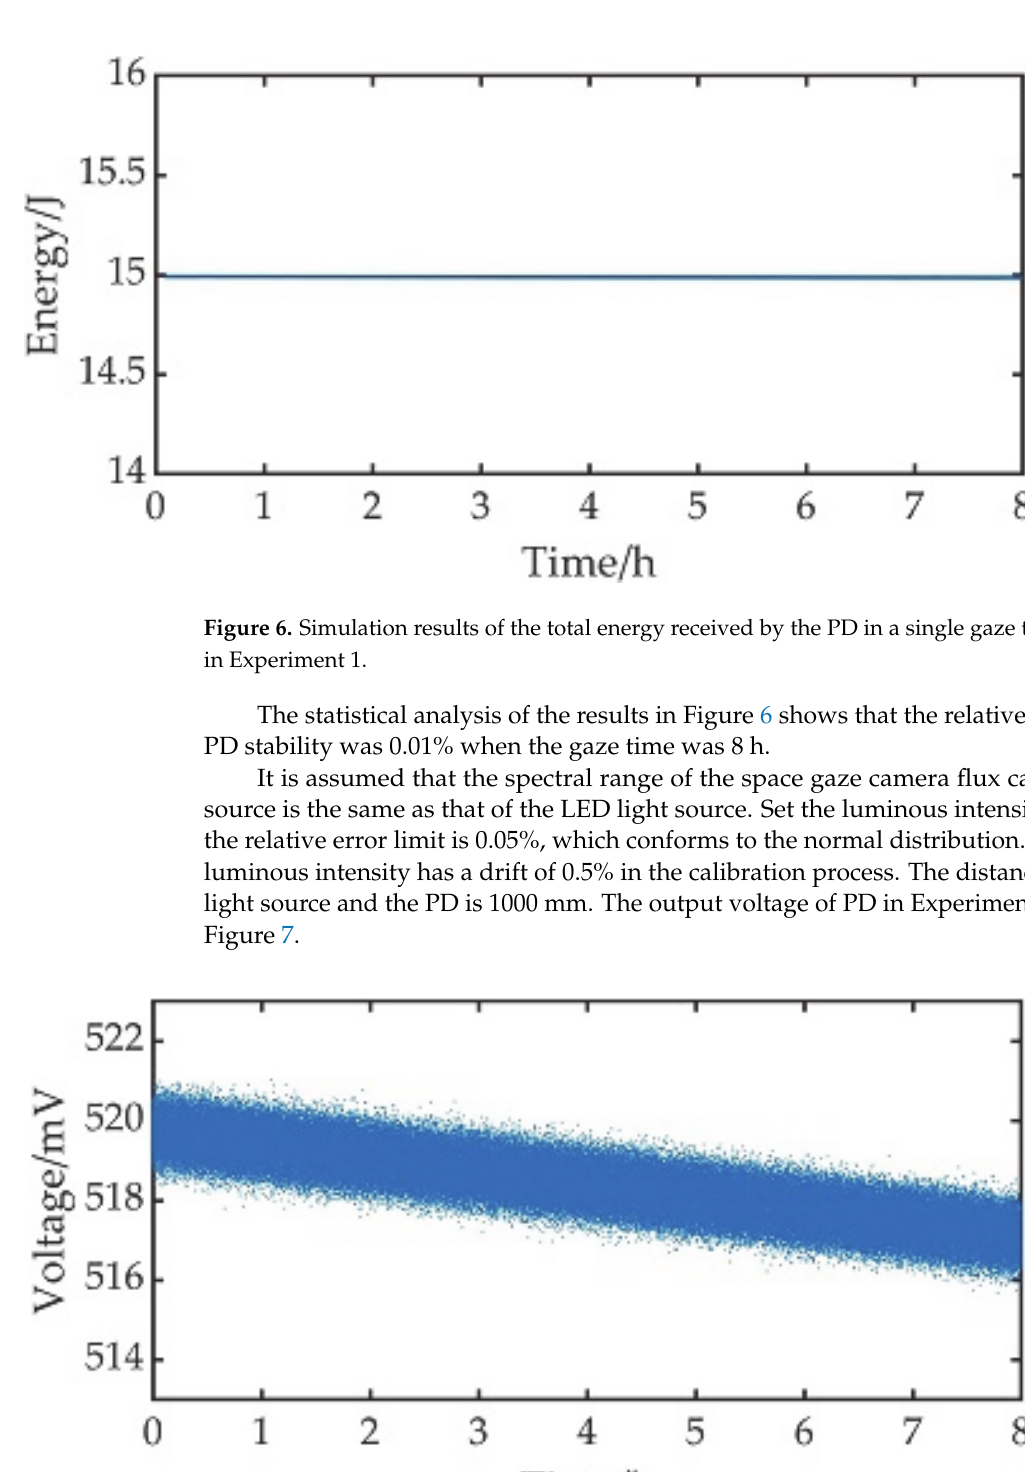
9 of 17 Figure 5. Simulation results of PD output voltage in Experiment 1.